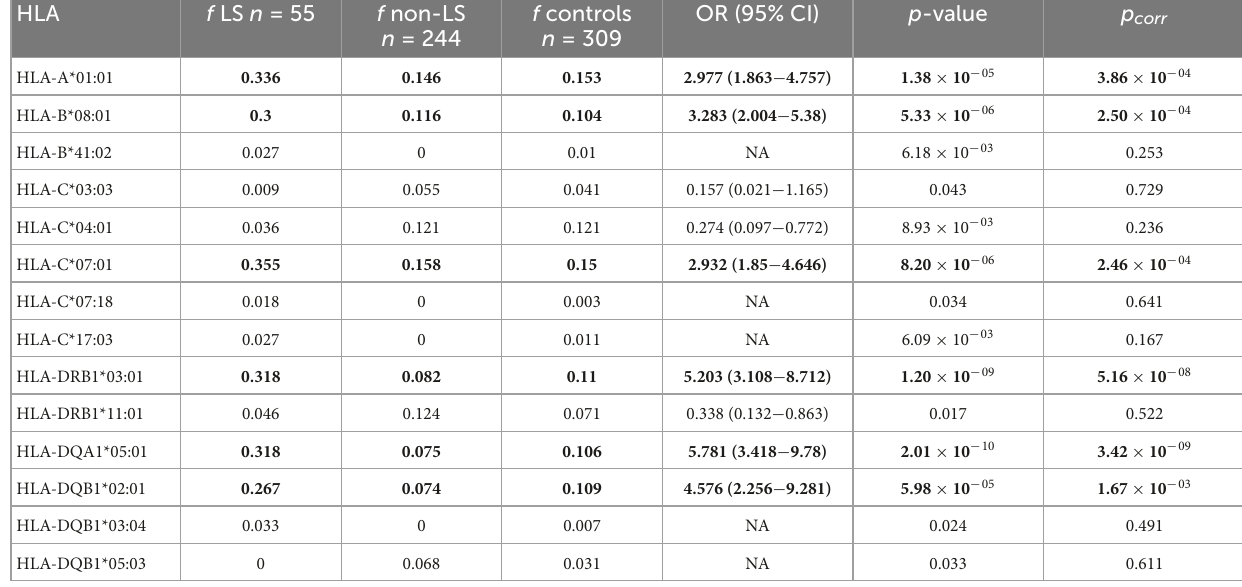
TABLE 3 Comparison of the HLA allele frequencies between the patients with Löfgren’s syndrome, LS ( n = 55) compared with the patients with non-LS ( n = 244). HLA f LS n = 55 f non-LS